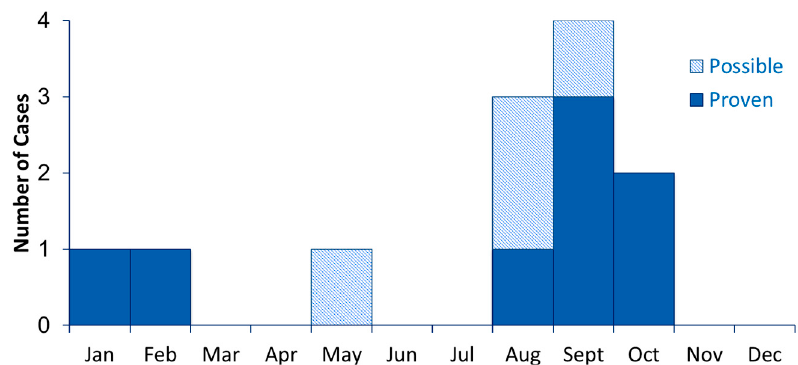
Figure 2. Sample epidemic curve, showing the number of proven and possible cases by month.